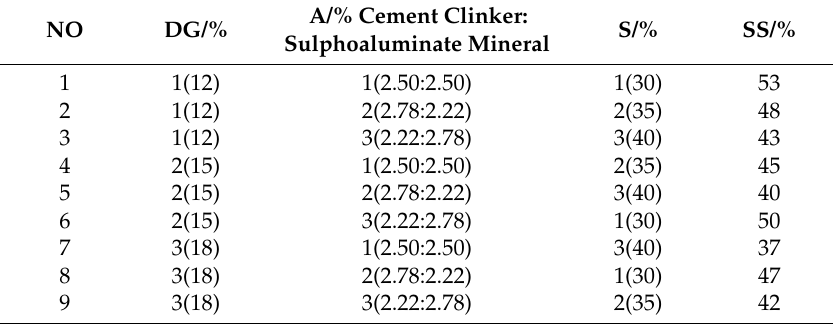
Table 4. Orthogonal test.